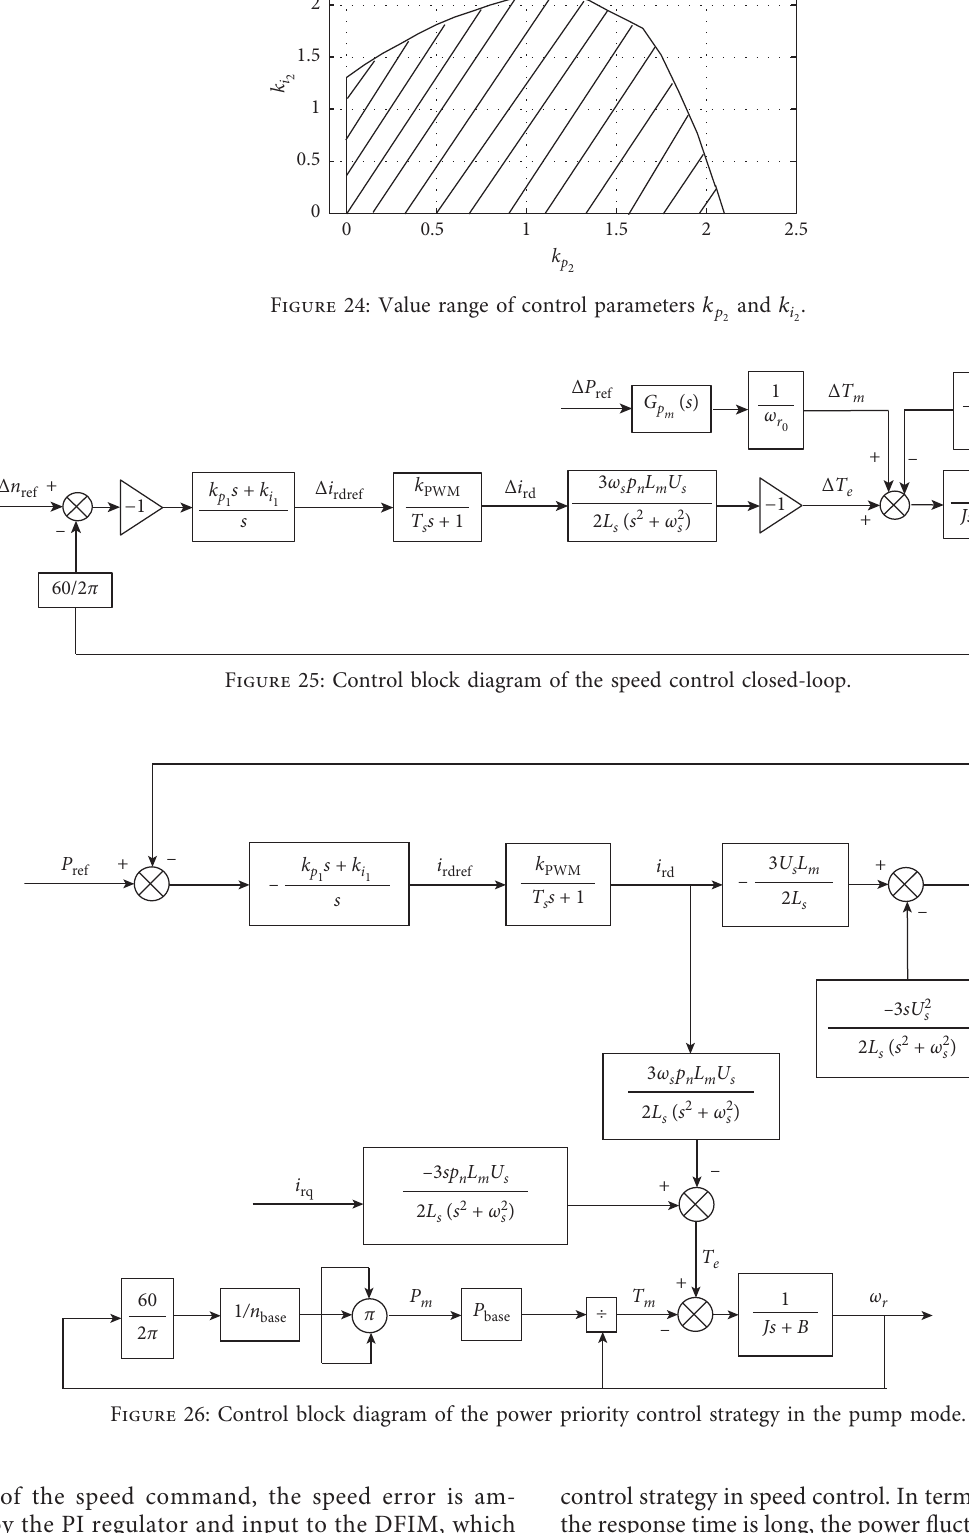
Figure 26: Control block diagram of the power priority control strategy in the pump